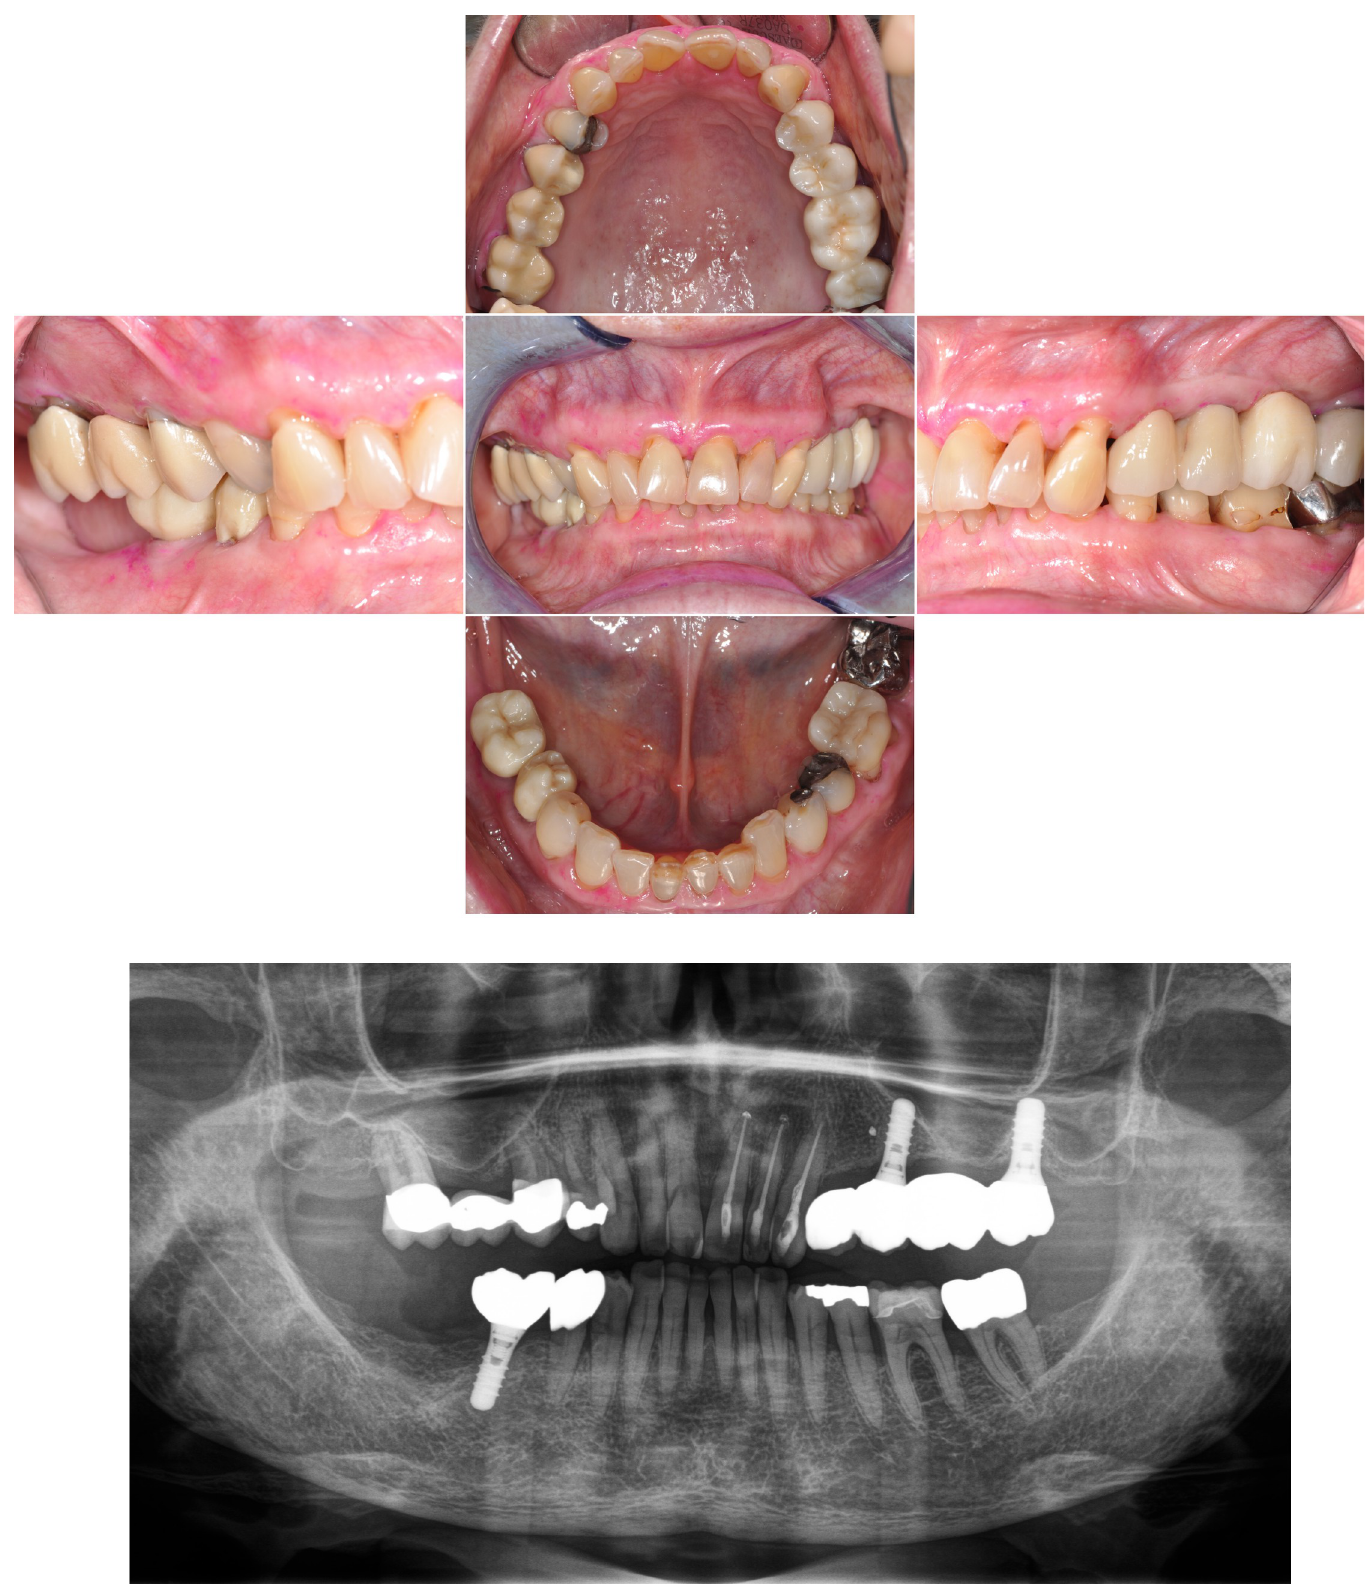
Fig 1. Exemplary intraoral digital photography status (A) and corresponding panoramic radiograph (B). https://doi.org/10.1371/journal.pone.0268360.g001 PLOS ONE | https://doi.org/10.1371/journal.pone.0268360 May 17,